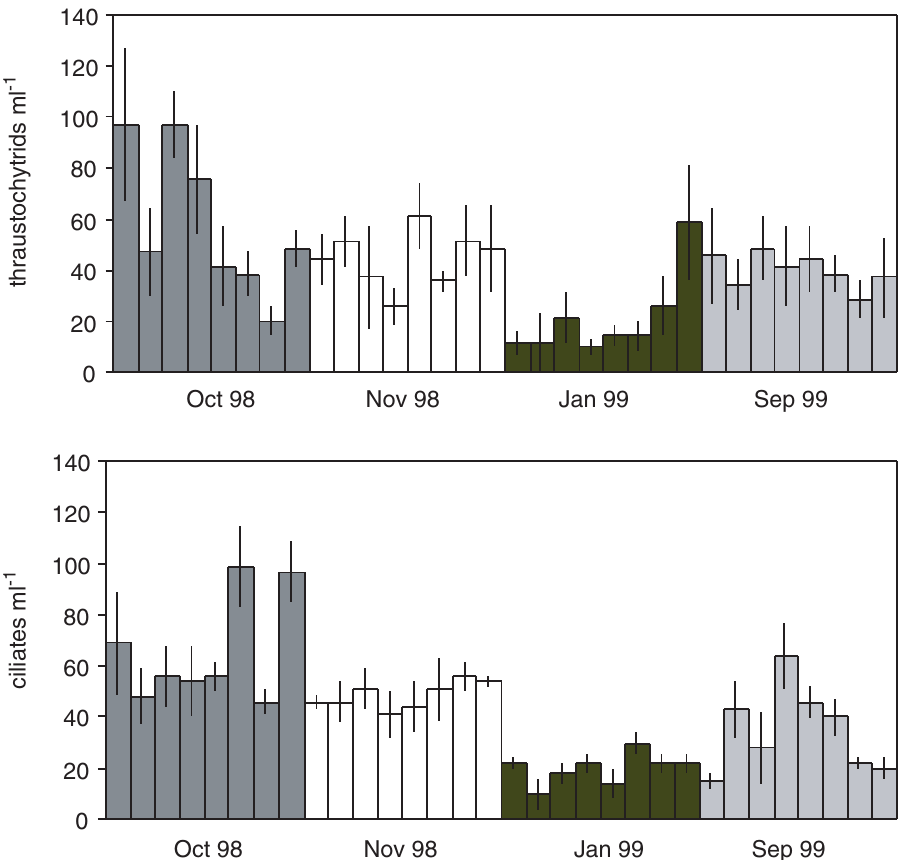
F IG . 2. – Thraustochytrid (A) and ciliate (B) densities (mean ± SE) in the four autumn-winter samplings (4 subplots, 4 replicates each).